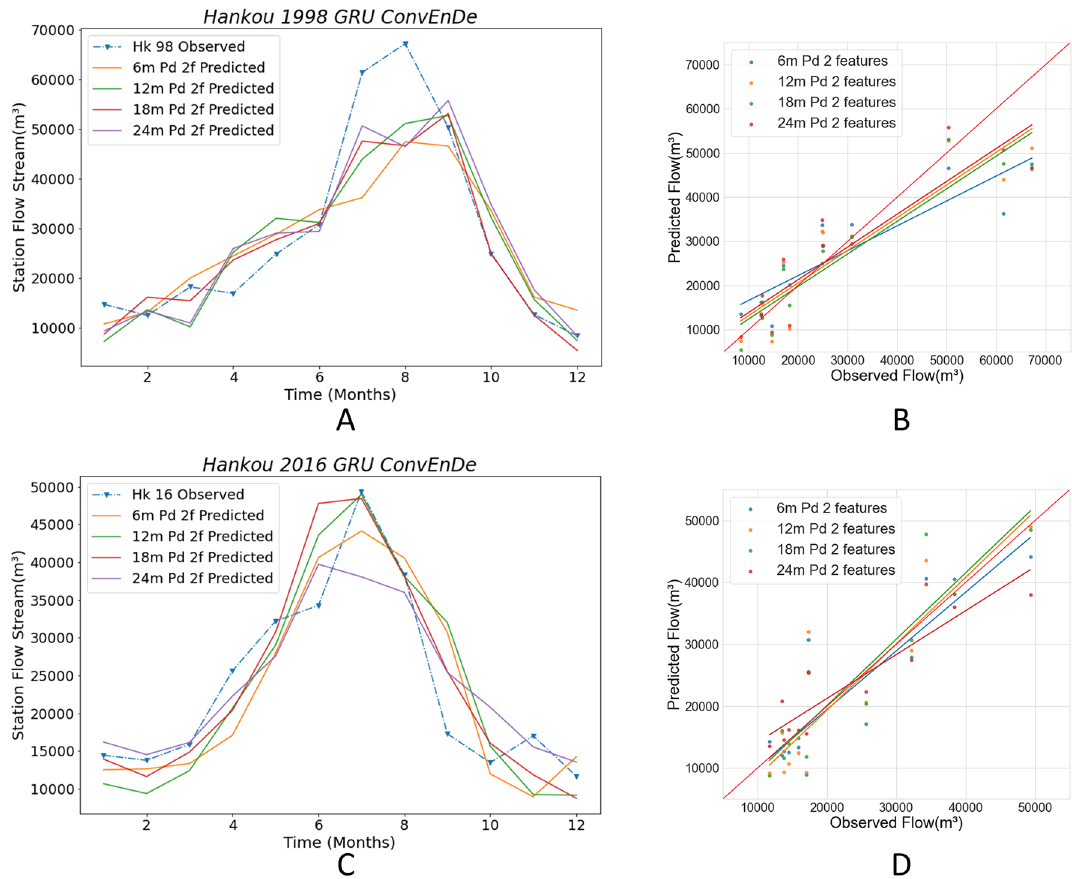
Figure 12. Comparison among the Conv encoder–decoder GRU with different periods in Hankou station. The solid lines in A, C plot the predicted values using different periods of data, and the blue dashed lines are the observed values. ( B, D ) Scatter plots of predicted and observed values for the four periods of data.